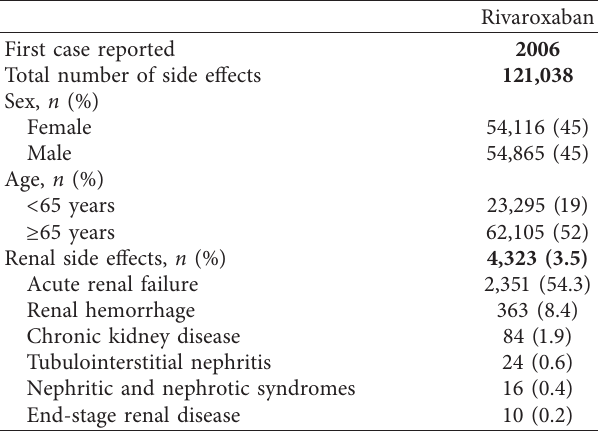
Table 3: Number and type of renal side effects reported for rivaroxaban (until 27 April 2019) retrieved from the VigiAccess database of the WHO Program for International Drug Monitoring (available at http://www.vigiaccess.org/).